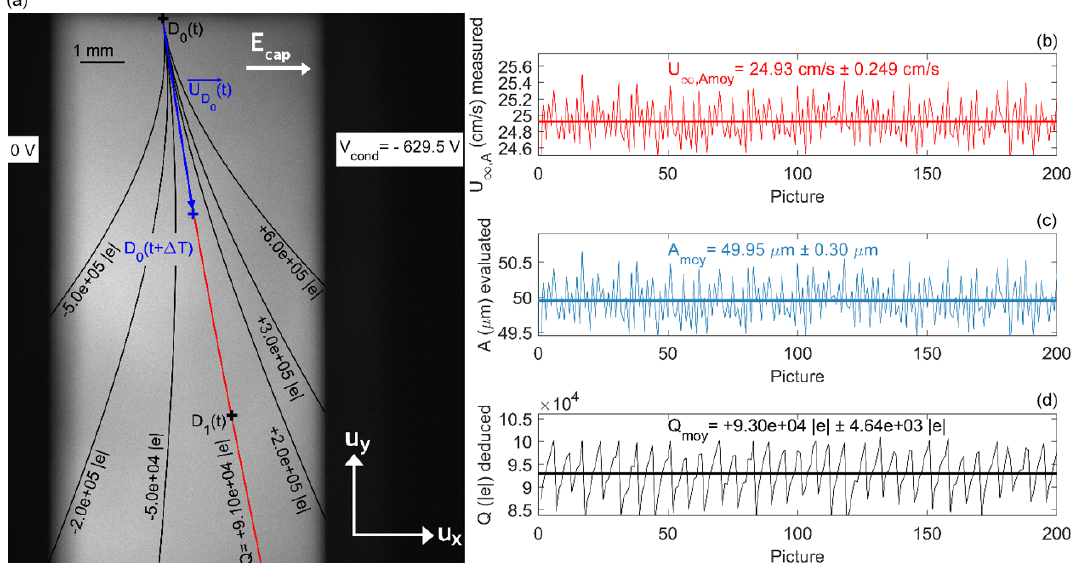
Figure B2. (a) Determination of the theoretical droplet trajectory which fits the best with the observed droplet positions – red line – and de- duction of the droplet charge ( Q ). In this example, V ind = − 32 . 25V, V cap = − 629 . 5V, A = 49 . 5µm and the air temperature T air = 292 . 55K. (b) Terminal velocity measurement, (c) droplet radius evaluation by reversing the Beard (1976) model and (d) droplet charge deduction for a series of 200 pictures pairs. Mean and standard deviations for the corresponding parameters are